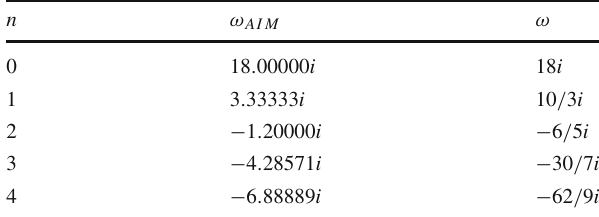
Table 1 QNFs for massless scalar fields with (cid:4) = 1 , m = 3 in the background of tree-dimensional extreme dilaton black